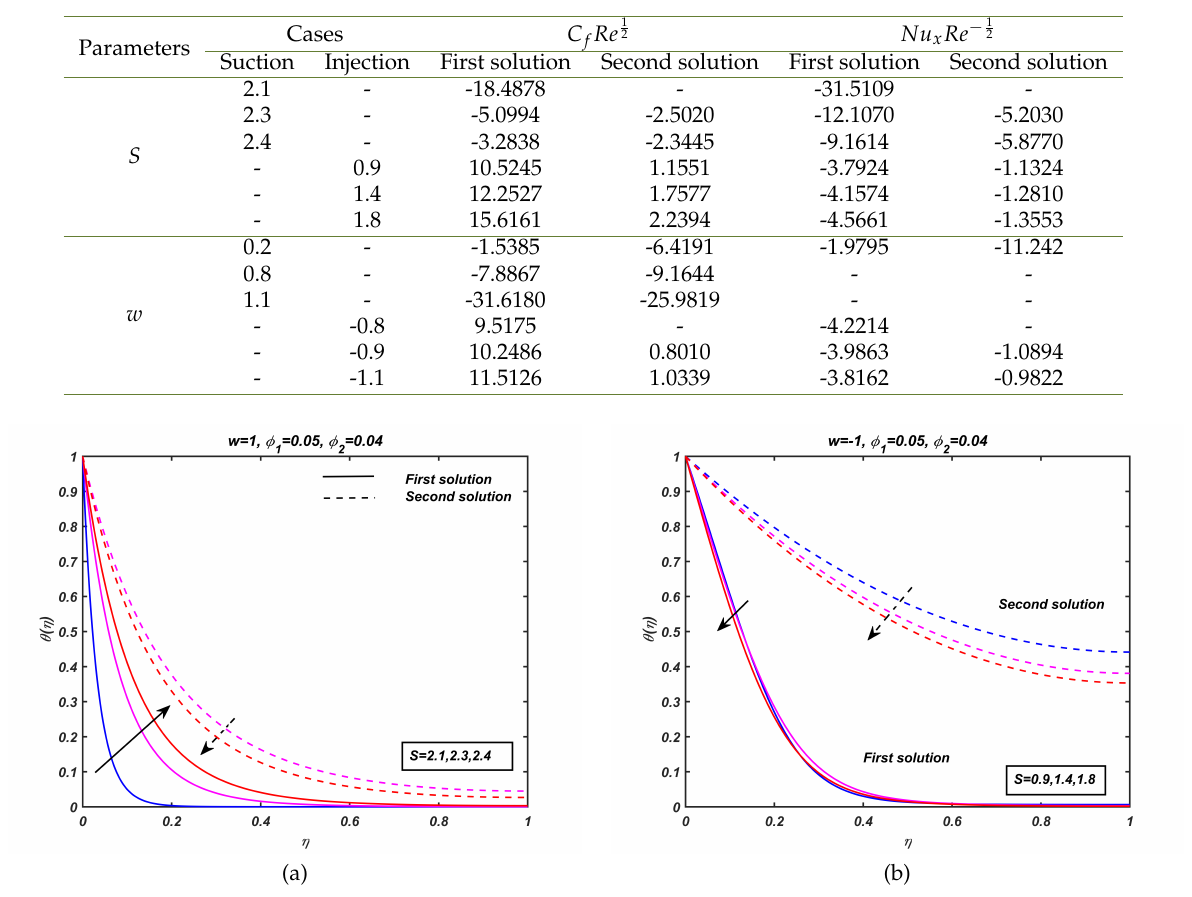
Fig. 4. Effect of S on temperature for suction case (a) and injection case